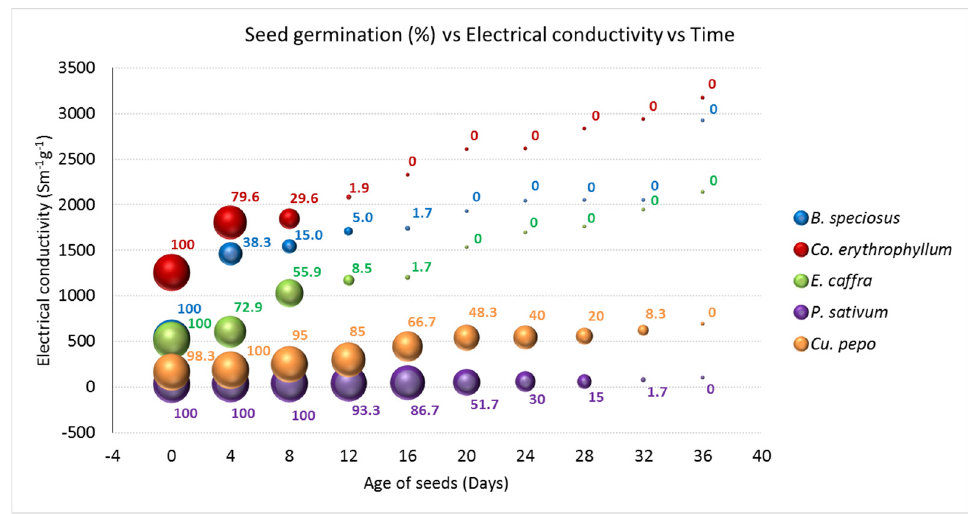
Figure 4. Germination and electrolyte leakage in Pisum sativum , Cucurbita pepo , Erythrina caffra , Bolusanthus speciosus , and Combretum erythrophyllum subjected to controlled deterioration at 40 ° C and 100% relative humidity for 36 d. Samples were taken at an interval of 4 d. The samples were subjected to both germination and electrolyte conductivity measurements.